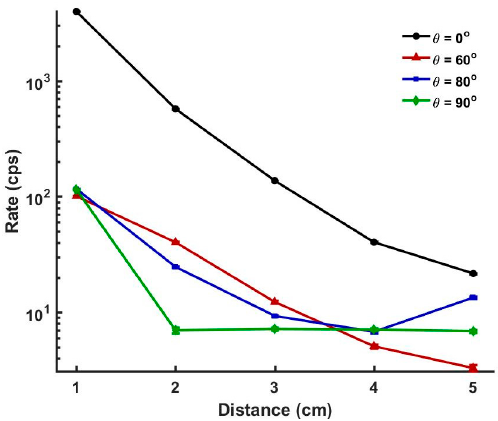
Figure 3. The r-dependence of superradiant Rayleigh scatterings of M4 γ at 662 keV in cps as a function of the 137 Cs source location of (r, θ ). Data listed in Table 3 were taken every five minutes. Table 3. R-dependence of superradiant Rayleigh in cps as a function of source location of (r, θ ). The source was 2.5 mCi 137 Cs. A nodal point appeared at (3.5 cm, 80 ° ), while the nearby low superradiances were at (3.3 cm, 60 ° ) and (3.7 cm, 90 ° ). Note that the normal value of the internal γ at 1121 keV was 6.92 ± 0.01 cps. The readings at (1 cm, 0 ° ) were lower than the real values, because of the pile-up loss of 48% dead time. The internal γ at 1121 keV was slightly increased by the 137 Cs bombardment.